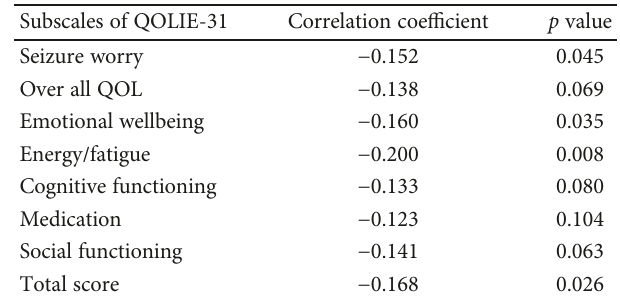
Table 2: QOLIE-31 subscale score among patients with epilepsy in ACSH and Mekelle Hospital.